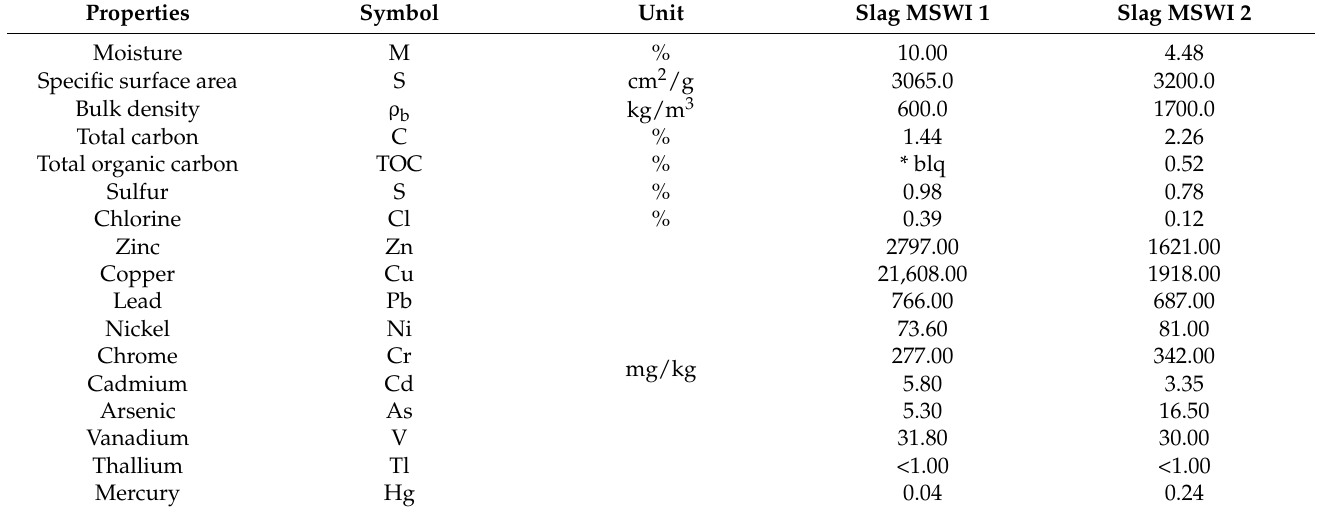
Table 3. Basic technical properties of tested